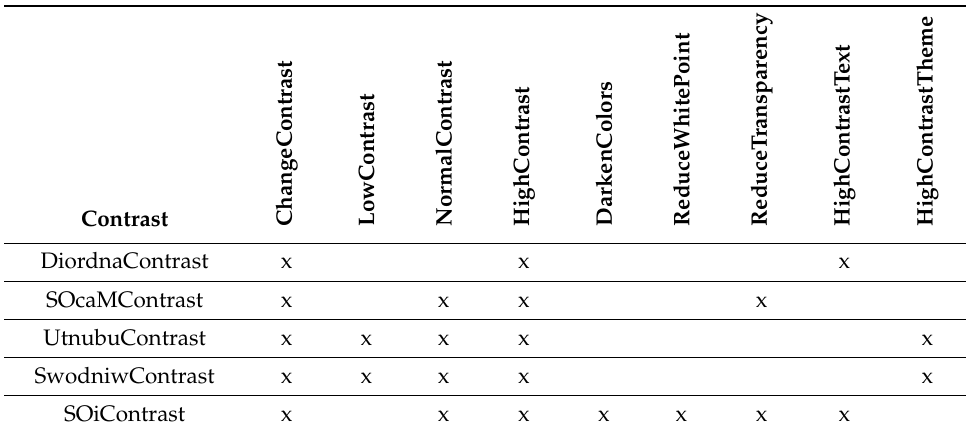
Table 3. Formal context Contrast for the fictitious example.